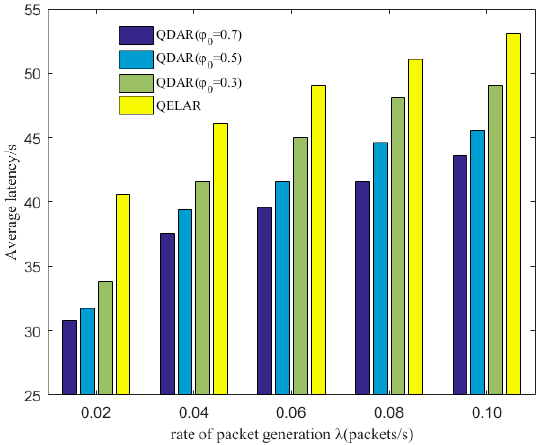
Figure 5. Average latency comparison between QDAR and QELAR with different packet generation rate λ (packets/s).